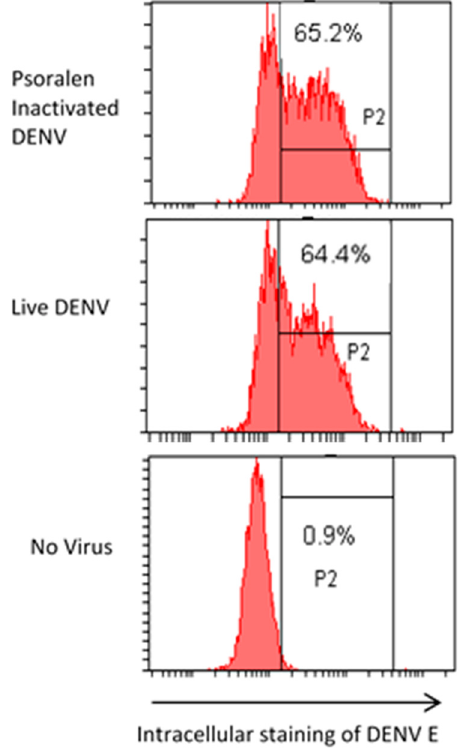
Figure 4. Intracellular staining of dendritic cell-specific intercellular adhesion molecule-3-grabbing non-integrin (DC-SIGN) receptor-expressing cells incubated with inactivated, live, or no Dengue-2 virus (DENV). The proportion of cells to the right of the first vertical line is the proportion that were stained for the DENV E protein (3H5).